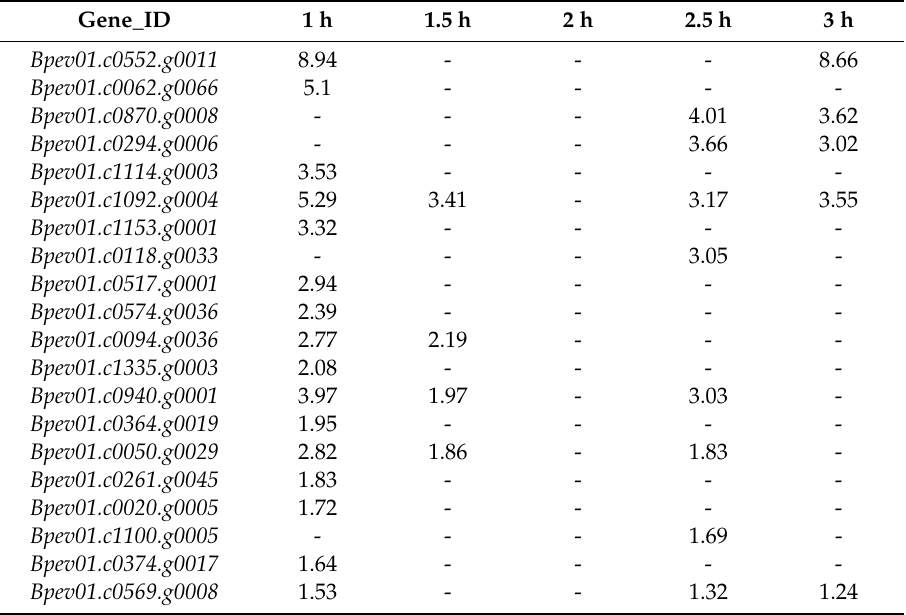
Table A7. DEGs related to lipid metabolism pathway under low-temperature stress in